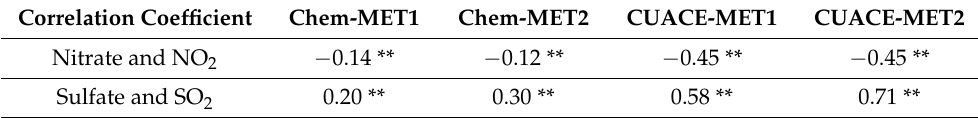
Table 9. Correlation Coefficients between nitrate and NO 2 , sulfate and SO 2 in the four tests.